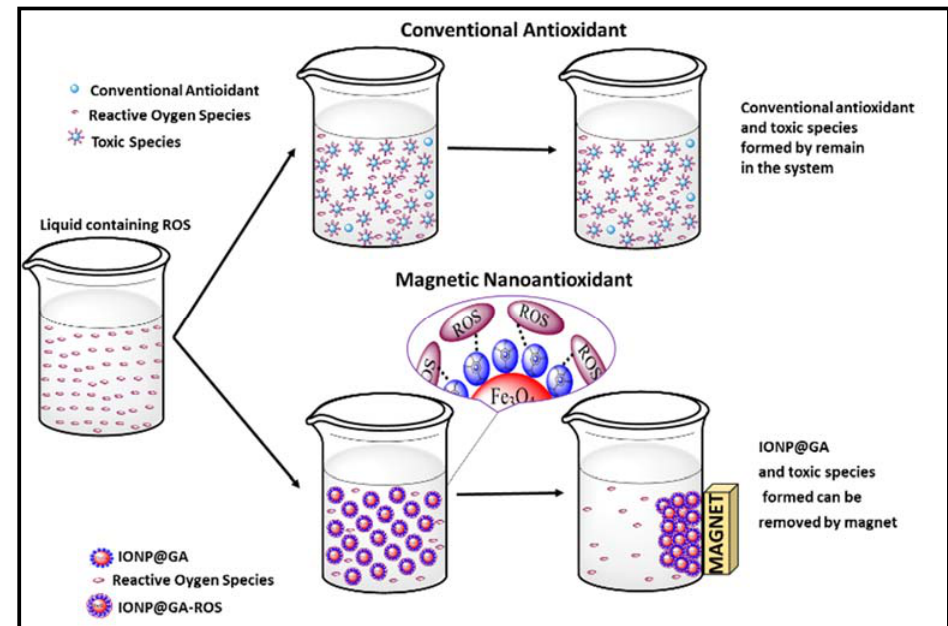
Figure 10. Proposed potential applications of IONP@GA in